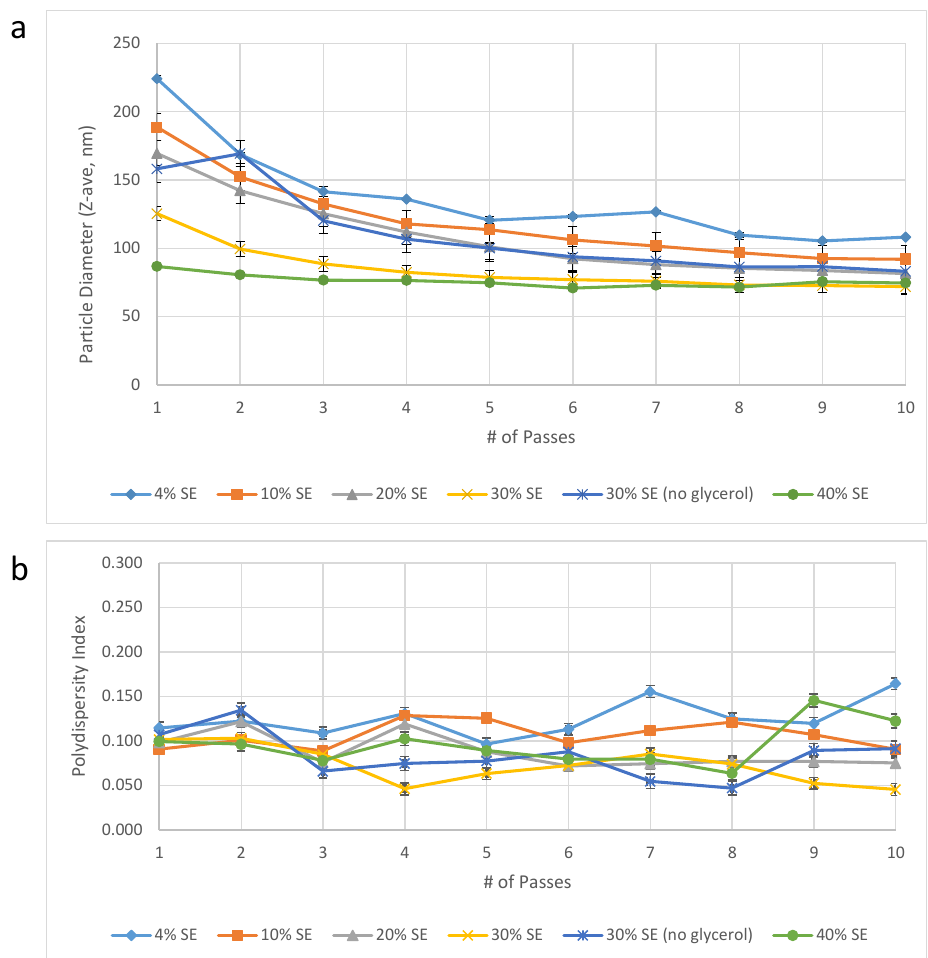
Figure 2. Emulsion droplet diameter ( a ) and polydispersity index ( b ) as a function of dispersed phase volume percent and number of Microfluidizer processing passes. Droplet diameter was measured within one month following manufacture. Error bars represent standard deviation of three measurements from one batch of emulsion produced at each dispersed phase content level. Note that the specific volume of DMPC was not accounted for, thus the concentration of DMPC and other aqueous phase excipients may have varied between ~1–13% from the target concentrations [13]. Table 3. Viscosity of oil and aqueous phases and corresponding emulsion particle size. Description *